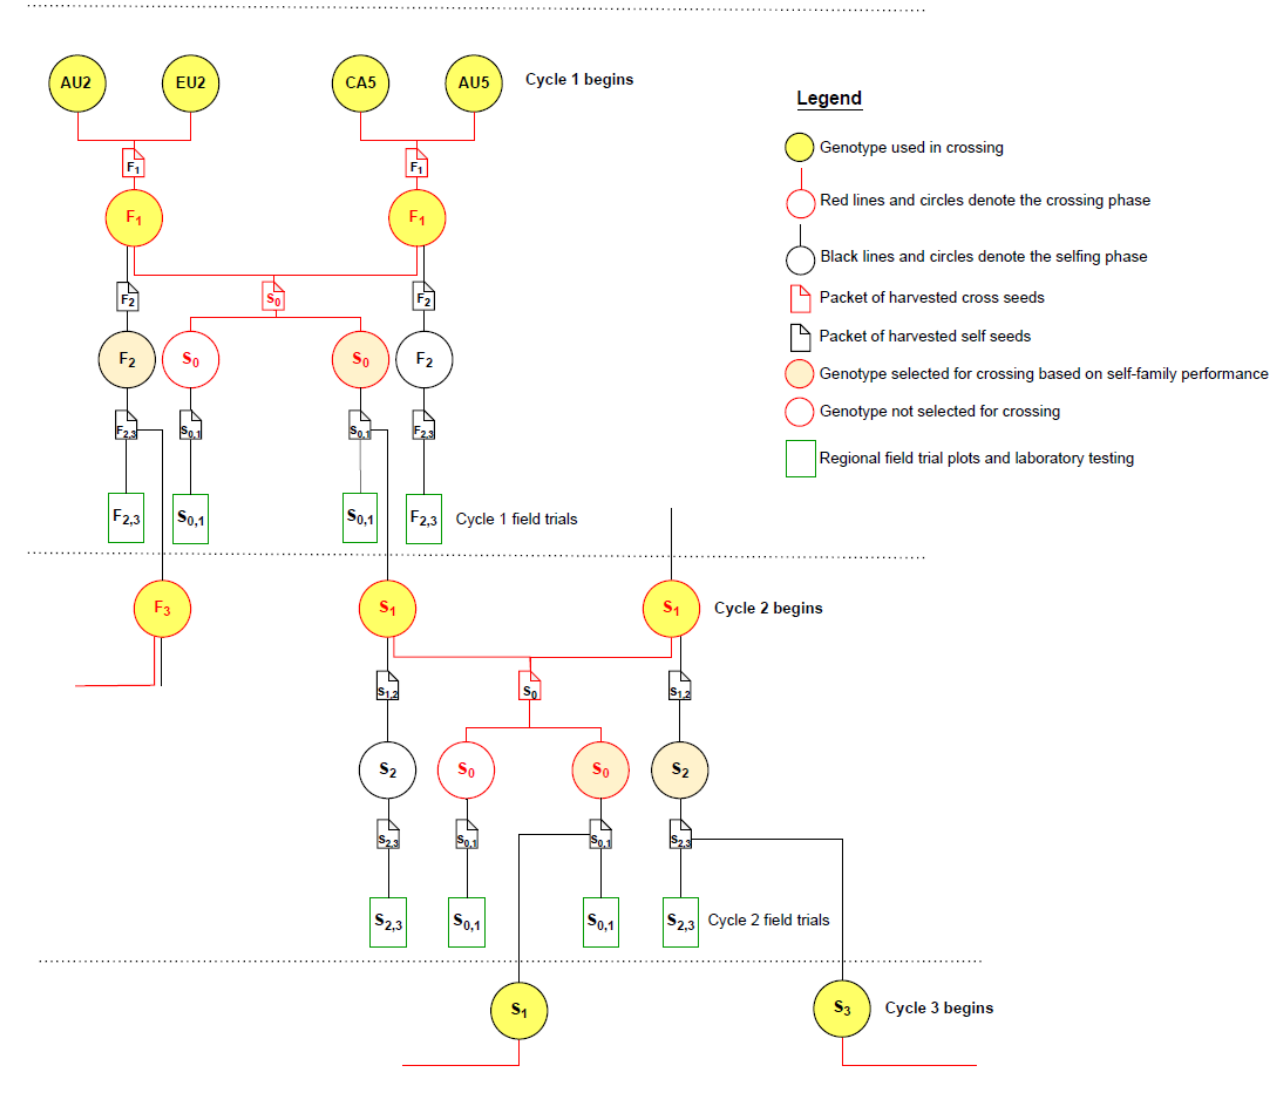
Figure 2. Two cycles of augmented S 0,1 family selection showing genotypes in the pedigree. In cycle 1, inbred founder parents from Australia (AU) were crossed with parents from Europe (EU) or Canada (CA), and their F 1 progeny were intercrossed to generate S 0 and F 2 progeny (circles). Individual S 0 and F 2 progeny were selfed and the self-seed was sown in S 0,1 and F 2,3 plots in cycle 1 field trials (rectangles). Phenotypic data from S 0,1 and F 2,3 plots in cycle 1 field trials were used to calculate the predicted breeding value of S 0 and F 2 progeny. Crossing in cycle 2 was based on remnant S 0,1 or F 2,3 seed of superior S 0 and F 2 progeny. A similar process occurred in cycle 2, with phenotypic data from S 0,1 and S 2,3 plots used to assess the predicted breeding value of S 0 and S 2 progeny genotypes, respectively. From cycle 2 onwards, selection was based on an economic index composed of all traits, and mating designs were derived from optimal contributions selection.